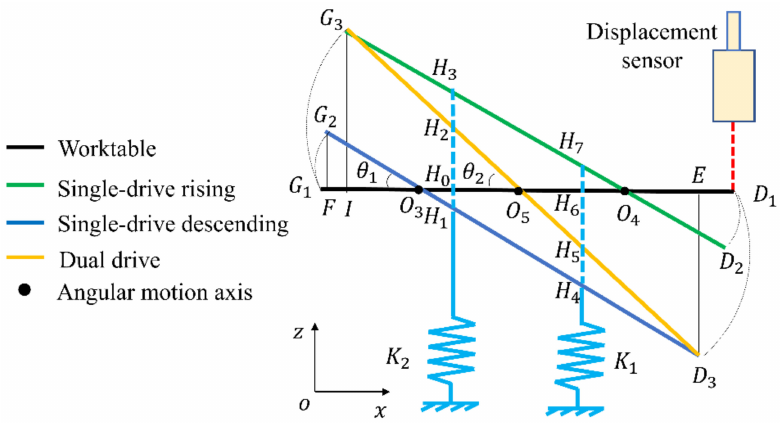
Figure 4. Schematic diagram of worktable motion track.